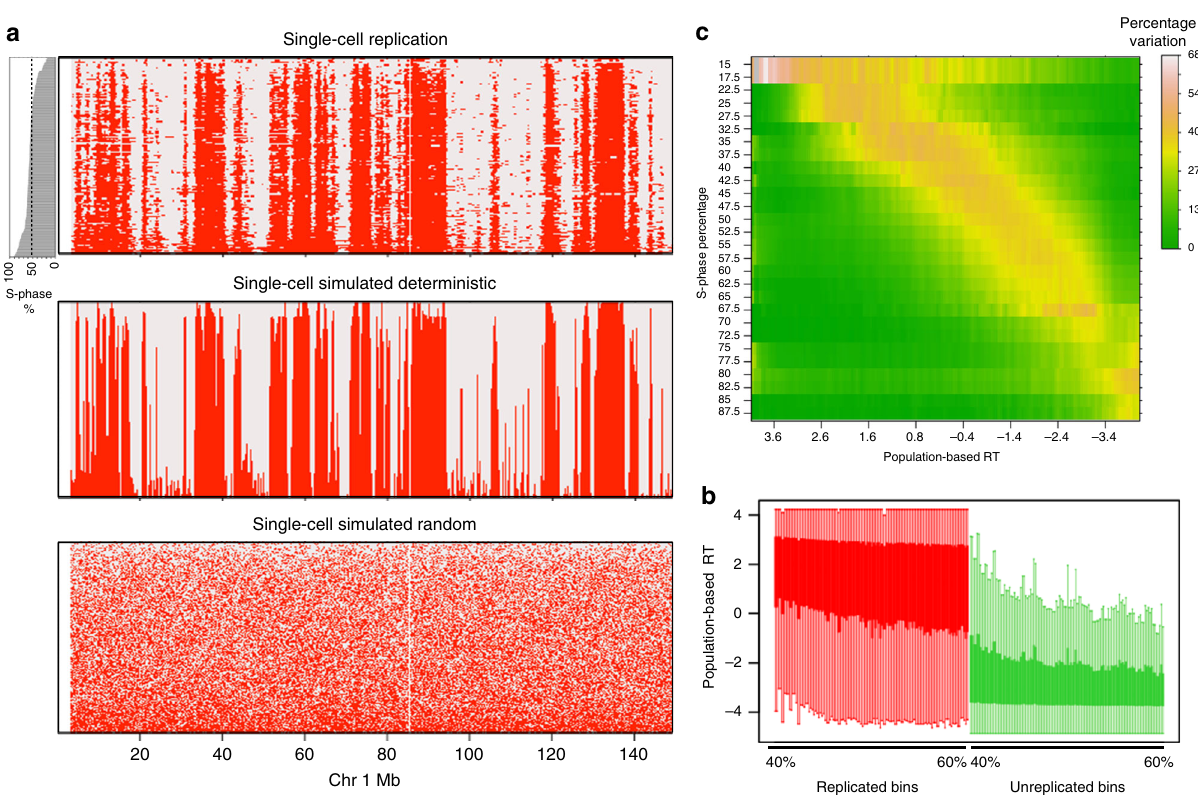
Fig. 2 Binarized single-cell replication. a Binarized replication status in all haploid single cells and homolog-parsed diploid cells. The cells are ranked by their progress in S-phase, which is plotted as a bar plot on the left. The bottom panels show simulated deterministic and random replication for the identical S- phase distribution of single cells (Methods). b Boxplot of population-based replication timing for replicated (red) and unreplicated (green) bins for each single-cell ranked between 40 and 60% S-phase progression. c Heatmap of variability between pairs of cells ranked within one percentile of each other. The Y axis is average S-phase rank of pairs of cells (all pairs ranked within 1% of S phase), measured in intervals of 5% of S-phase progression with a step size of 2.5. The x axis is the replication timing (RT) measured by population-based repli-seq, measured in intervals of 0.1 with a step size of 0.05. The pairwise variability between cells (measured using the binarized data) is the percentage of 50 kb bins where there is a transition in the binary signal for